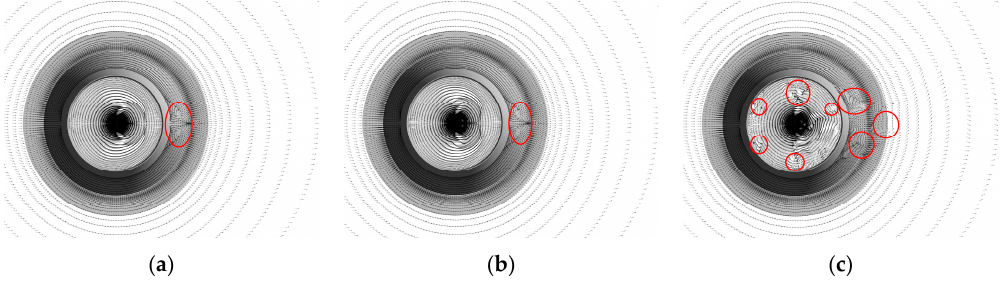
Figure 25. Comparisons of velocity vectors at horizontal plane (z = 85 m) of cooling tower: ( a ) RANS; ( b ) URANS; ( c ) LES.